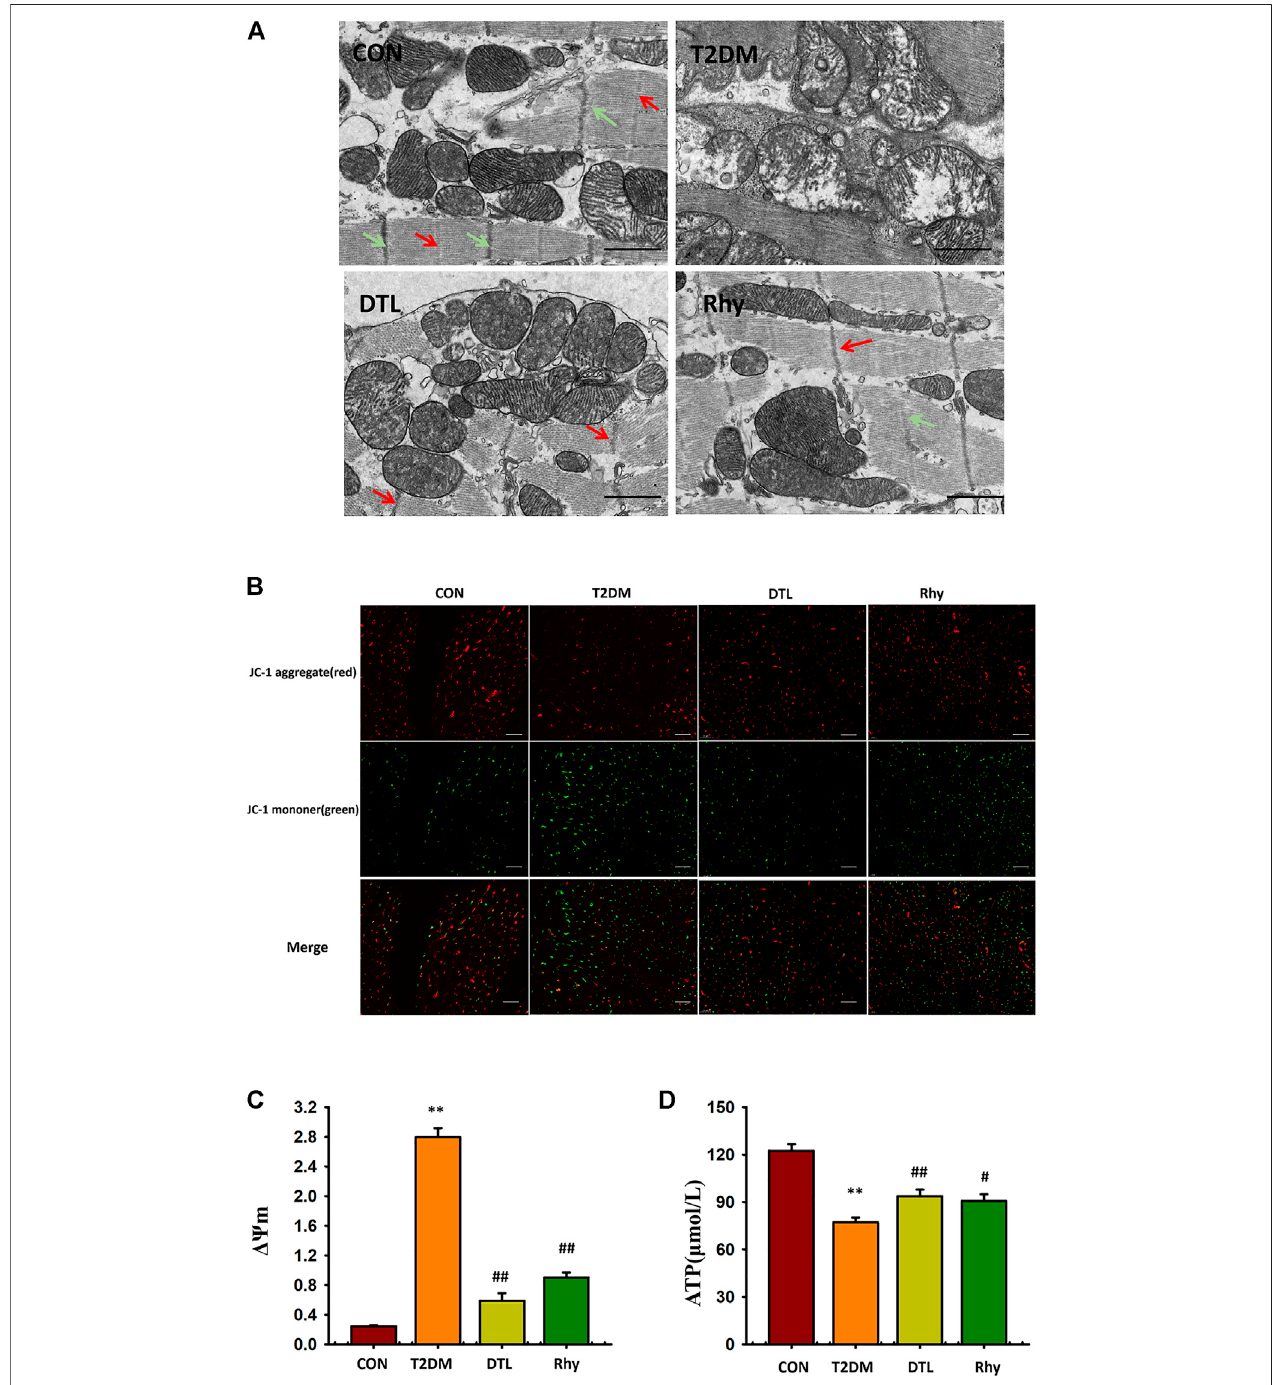
FIGURE 9 | Effect of rhynchophylline on the microstructure and mitochondria morphology of cardiomyocytes. (A) Representative sections of mouse cardiomyocytesobservedunderatransmissionelectronmicroscope. (B) Representativemitochondrialmembranepotentialobservedundera fl uorescencemicroscope (magni fi cation, ×200). (C) The dynamic change in ΔΨ m represented by the ratio of fl uorescence intensity of 527 and 590 nm. (D) Adenosine triphosphate content in myocardial tissue. Values are presented as mean ± standard error of the mean. ** p < 0.01 vs. control group; # p < 0.05, ## p < 0.01 vs. type 2 diabetes mellitus